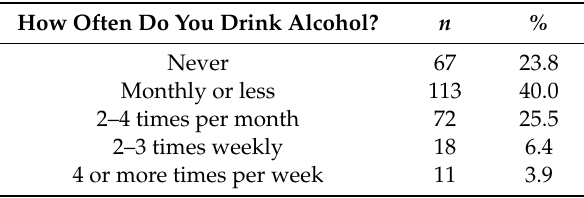
Table 3. Summary of alcohol drinking frequencies.